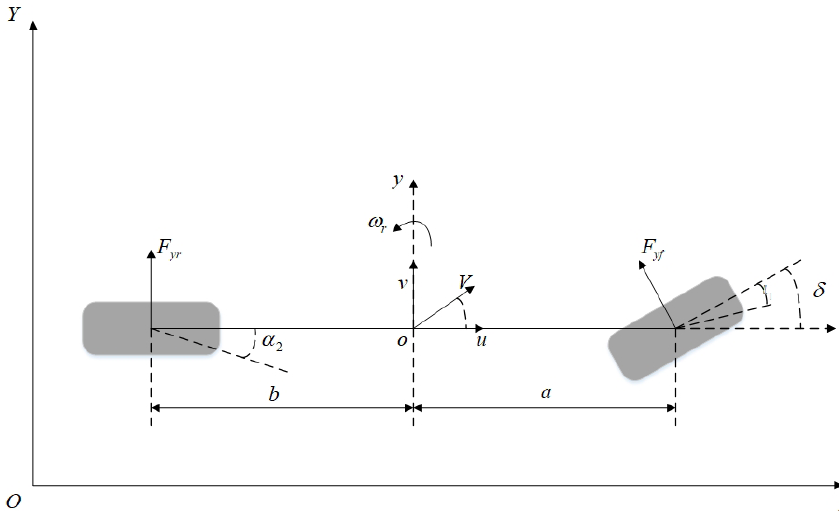
Figure 2. Vehicle model with 2 DOF.